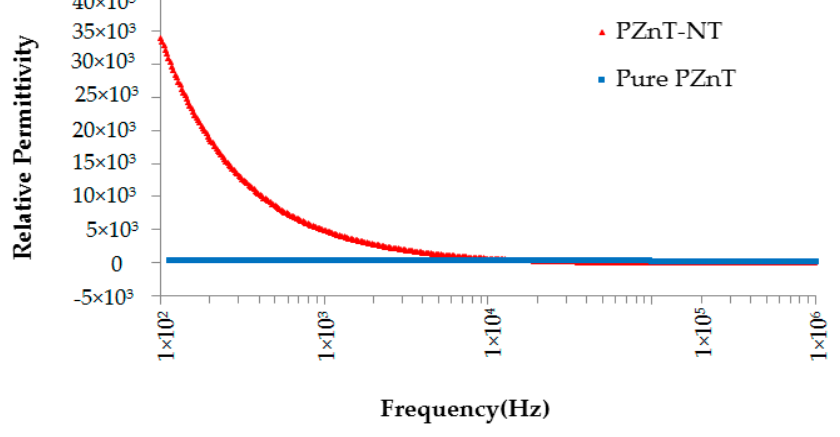
Figure 4. The dielectric properties of PZnT-NT.